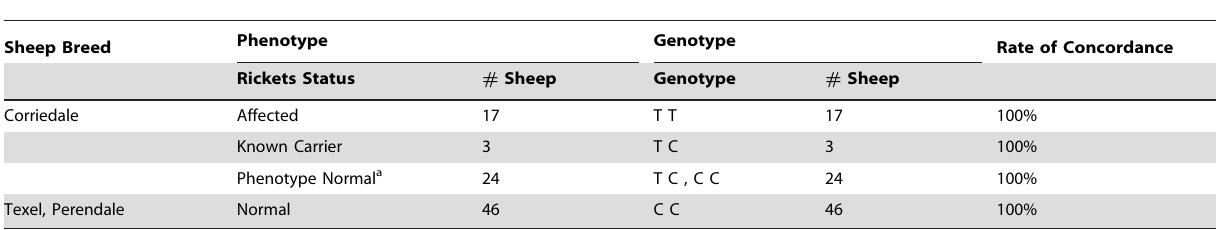
Table 1. The genotyping results of the causative mutation (R145X).